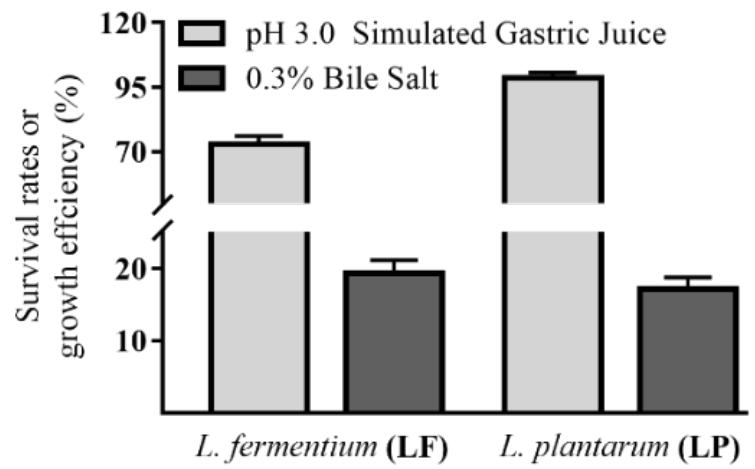
Figure 3. In vitro tolerance levels of LF and LP.